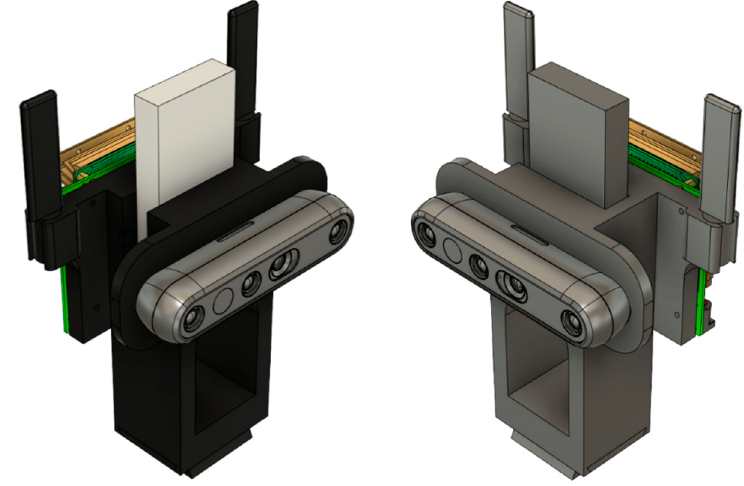
Figure 7. 3D Models of Case with Hardware.